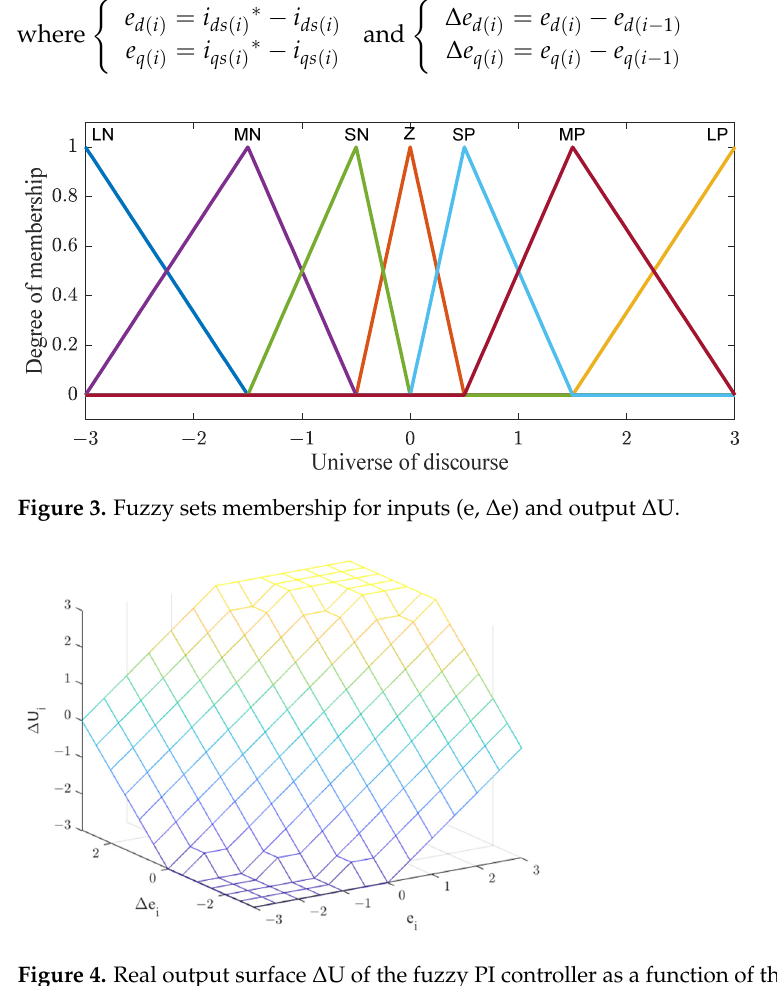
Table 1. Base of rules for